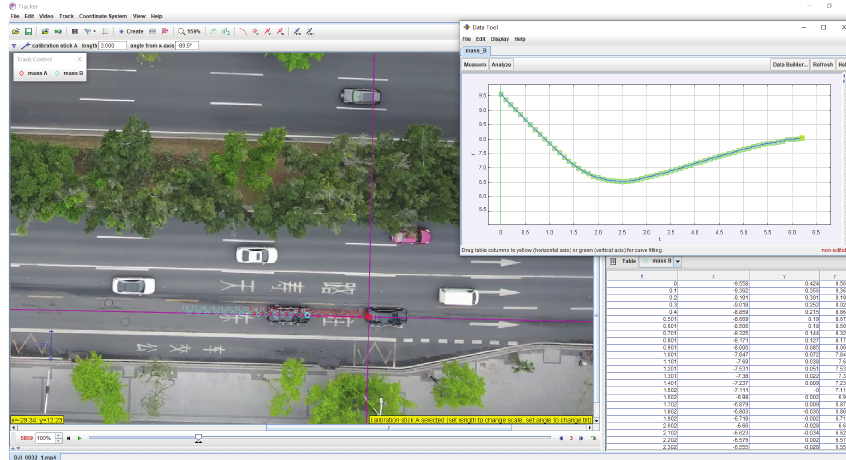
Figure 4: Schematic diagram of extracting rear-end